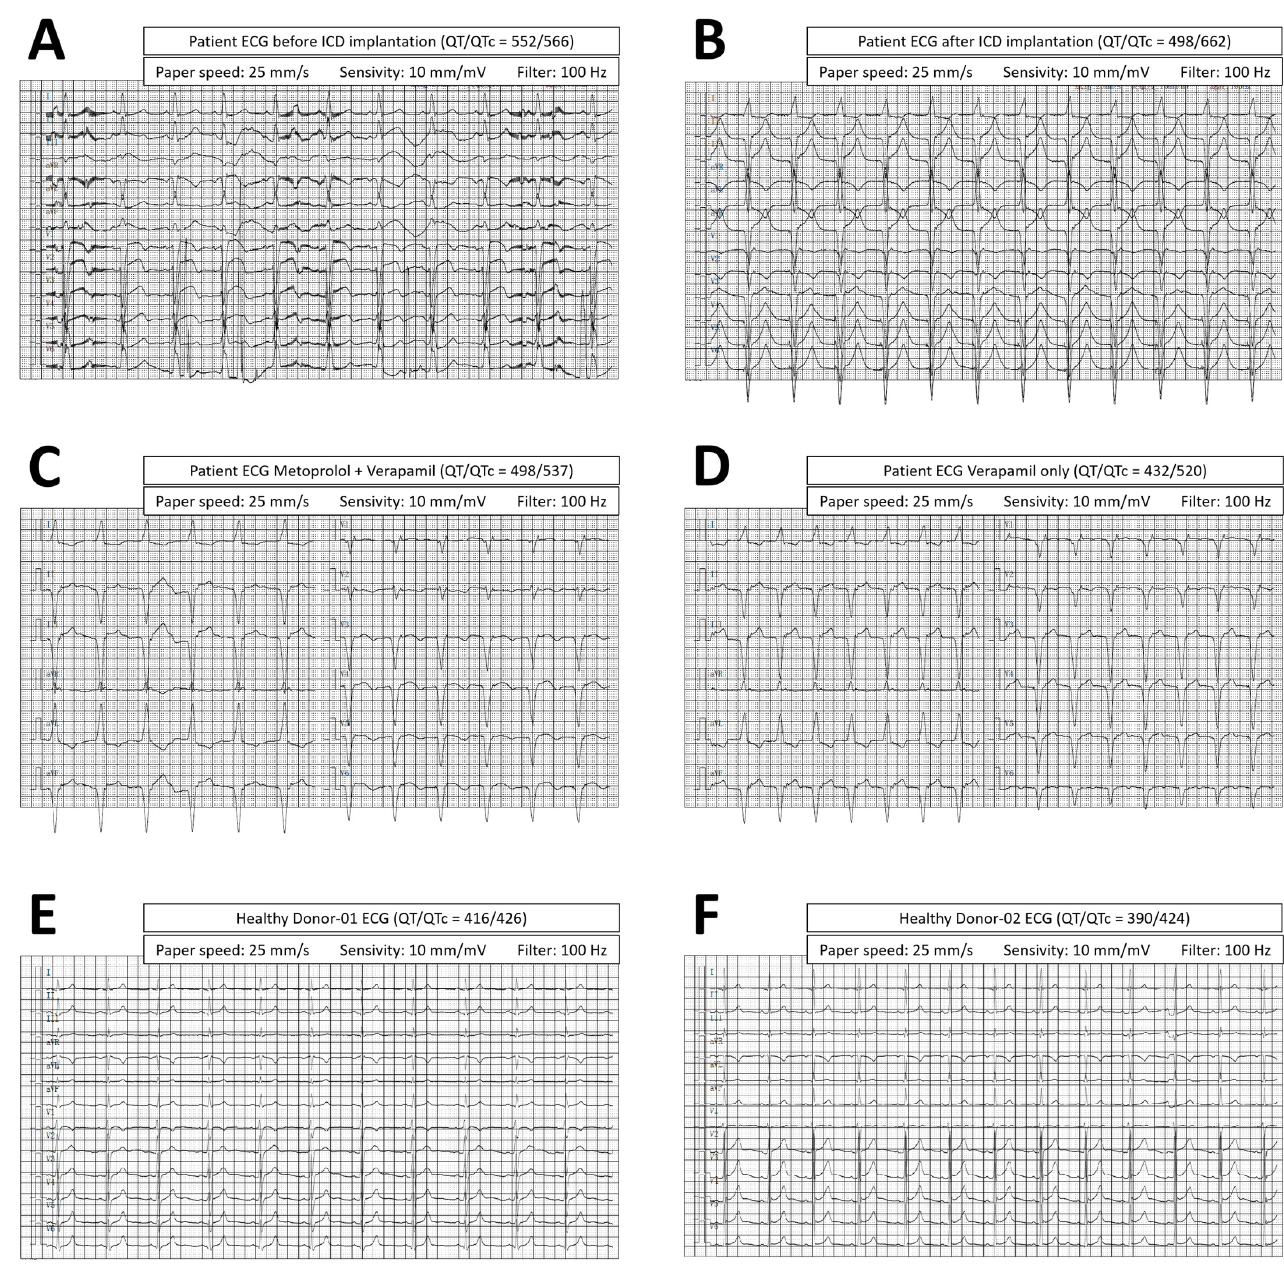
Figure 7. Effect of Verapamil on Patient ECG. Dual mutation patient demonstrated QT intervals of 552/566 and 498/662 before ICD implantation ( A ) and after ICD implantation ( B ), respectively. Patient QT intervals were found to be longer when compared to ECGs of healthy donor 01 (( E ), QT/QTc = 416/426) and 02 (( F ), QT/QTc = 390/424). Treatment using Metoprolol in combination with verapamil ( C ) or verapamil alone ( D ) both reduced QT interval and improved ECG wave form.